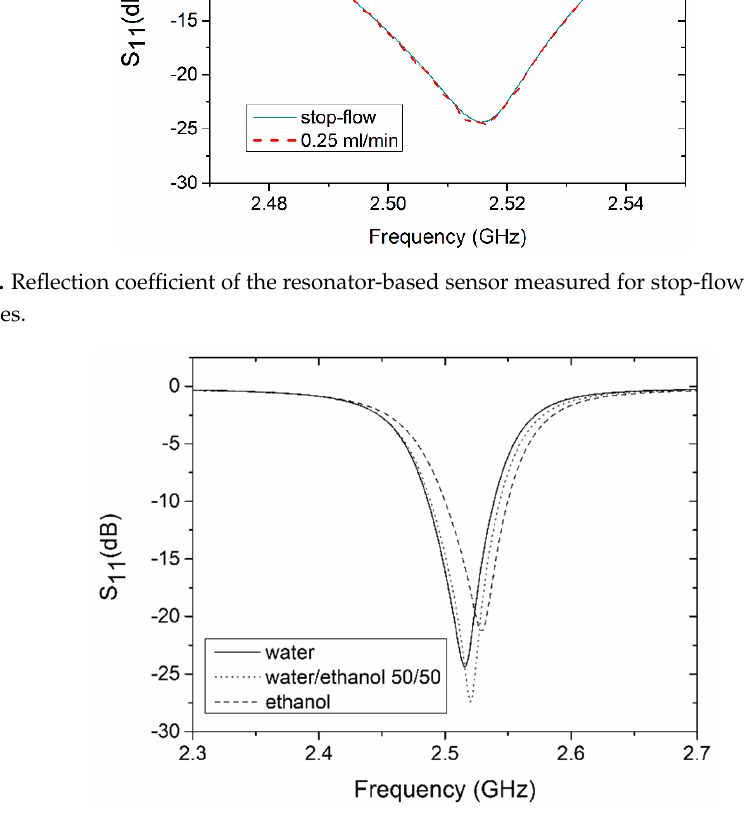
Figure 10. Reflection coefficient of the resonator-based sensor measured for stop-flow and continuous flow modes.